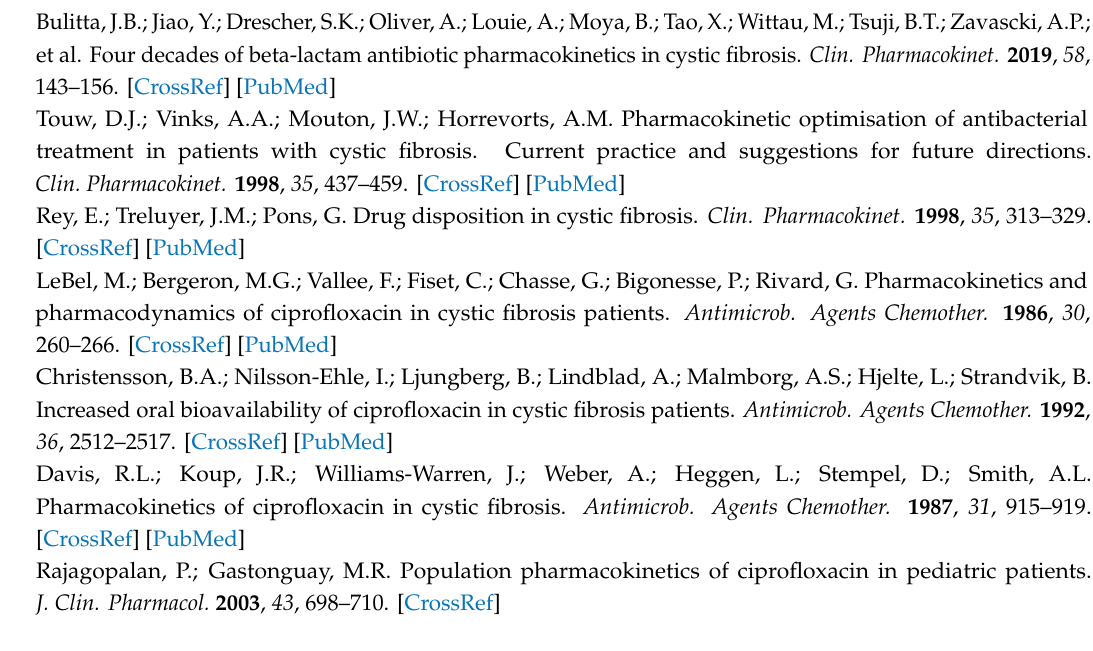
Figure S1: Observed vs. individual fitted plasma concentrations (top) and fractions of dose excreted in urine (rows 2 to 4) on linear (left side) and logarithmic scale (right side). The green line represents the line of identity and the dashed blue line a LOESS smoother, Figure S2: Observed vs. population fitted plasma concentrations (top) and fractions of dose excreted in urine (rows 2 to 4) on linear (left side) and logarithmic scale (right side). The green line represents the line of identity and the dashed blue line a LOESS smoother, Figure S3: Estimation code for the final model in SADAPT-TRAN format, Table S1: Estimates from the original dataset compared to the median and 95% confidence intervals from nonparametric bootstrapping (200 replicates) for the final population PK